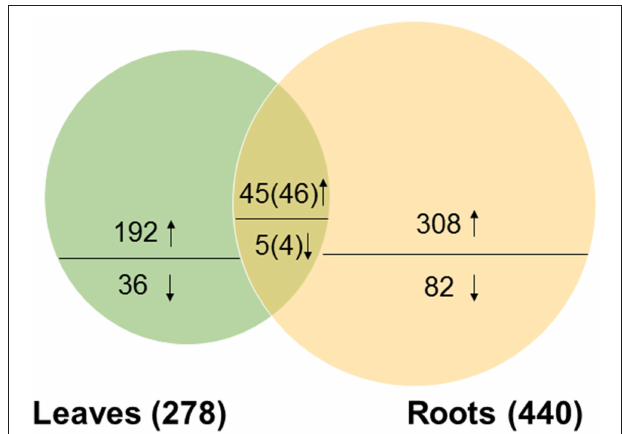
FIGURE 3 | Venn diagram of the distribution of differentially expressed proteins responsive to salt stress in soybean leaves and roots. The number above or below the horizontal line in each portion indicated the number of up-regulated or down-regulated proteins. The overlapping regions indicated the number of common proteins. Among the 50 common DEPs, 45 were up-regulated and 5 were down-regulated in leaves; and 46 were up-regulated and 4 were down-regulated in roots.